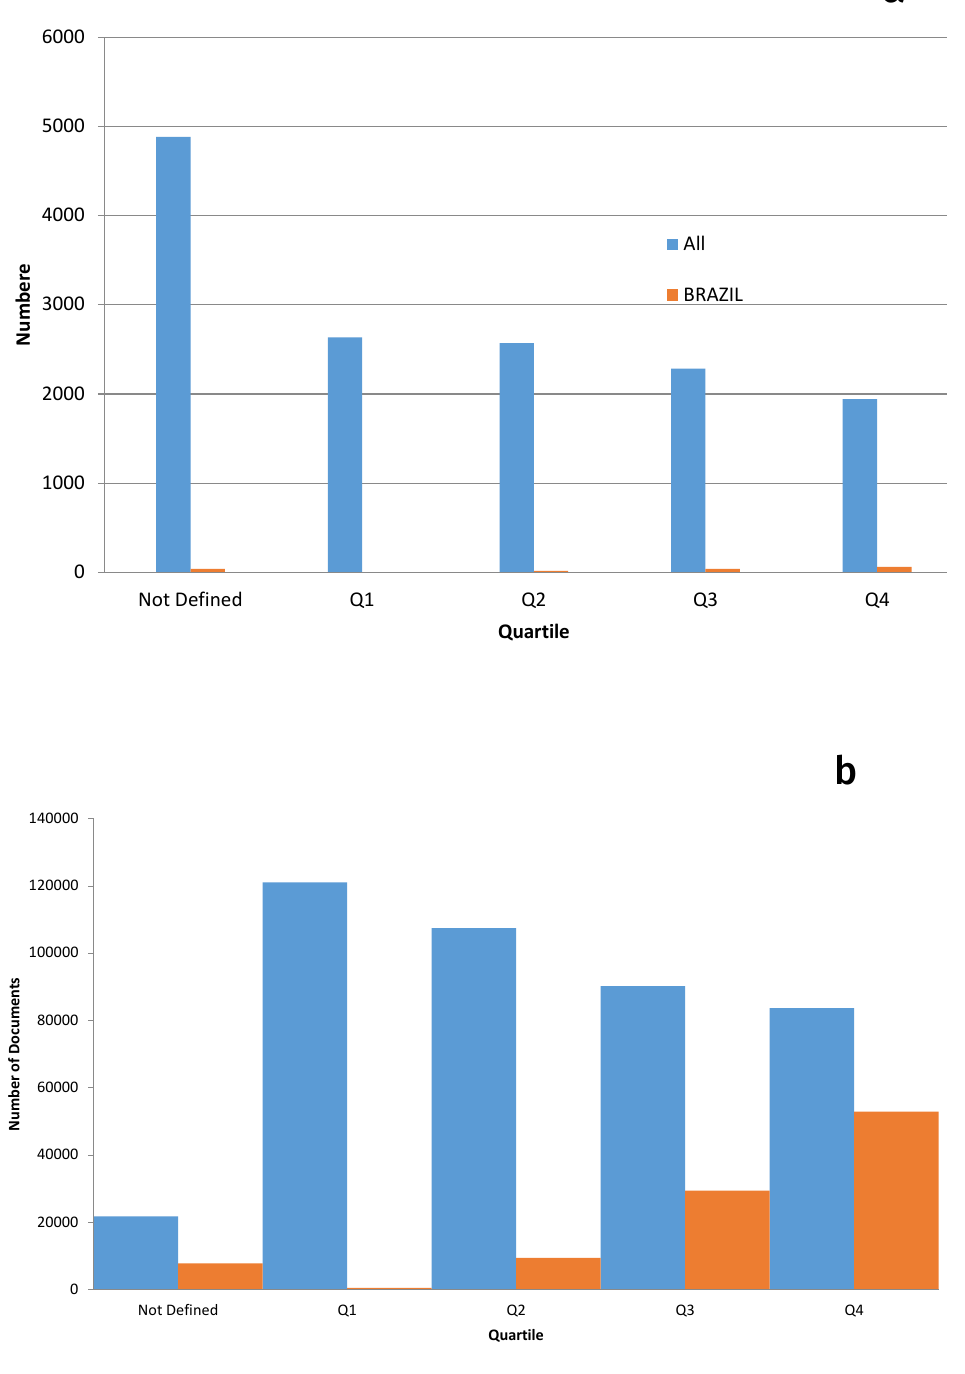
Figure 3. Distribution of journals (a) and Documents (b) by area of knowledge and journal quartile for publications from Brazilian Authors (Incites ®